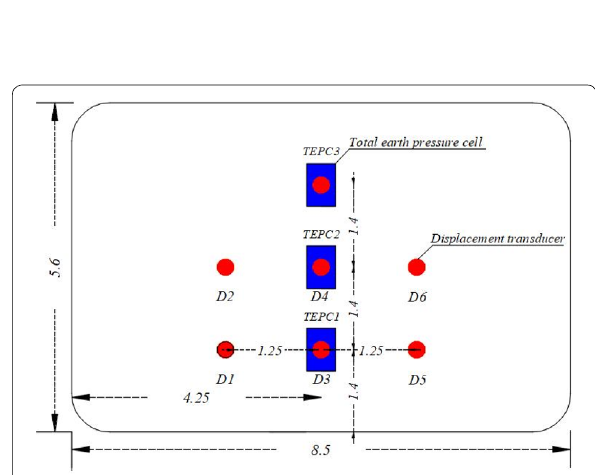
Fig. 3 Arrangement and distribution of the TEPCs and sensors on the barricade (dimension in m).